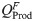
Changes in production question QProdF resulting from the combination of the local update of the internal model and the update of the auditory characterization of vowel /ɛ/.See Fig 11 for additional details.